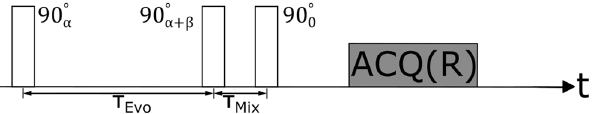
Figure 2. Pulse scheme of the TQTPPI pulse sequence, which consists of three 90° radio frequency excitation pulses with pulse phases α and β . The inter pulse delays are called evolution (T Evo ) and mixing time (T Mix ). During the phase cycle α and T Evo are incremented simultaneously while β is altered between 90° and 270°. The receiver for data acquisition is represented by